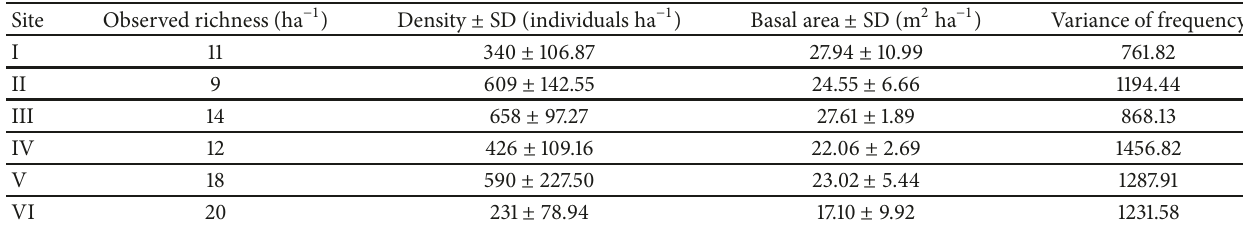
Table 3: Observed richness, total density, and total basal area along the sites of Janajagaran BZCF. Site Observed richness (ha −1